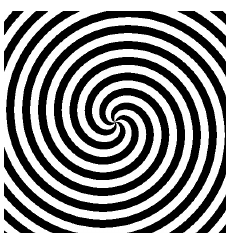
Figure 13. Helicoidal axicon intensity profile to be loaded in the LCoS SLM.